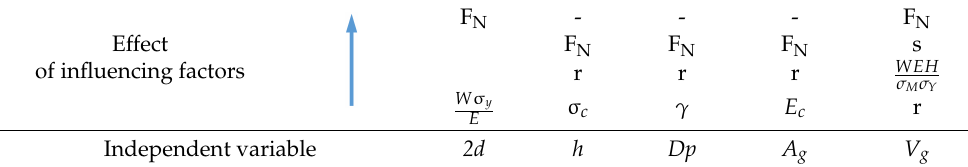
Table 9. Abrasive sensitivity ranking to single-asperity scratch system variables.